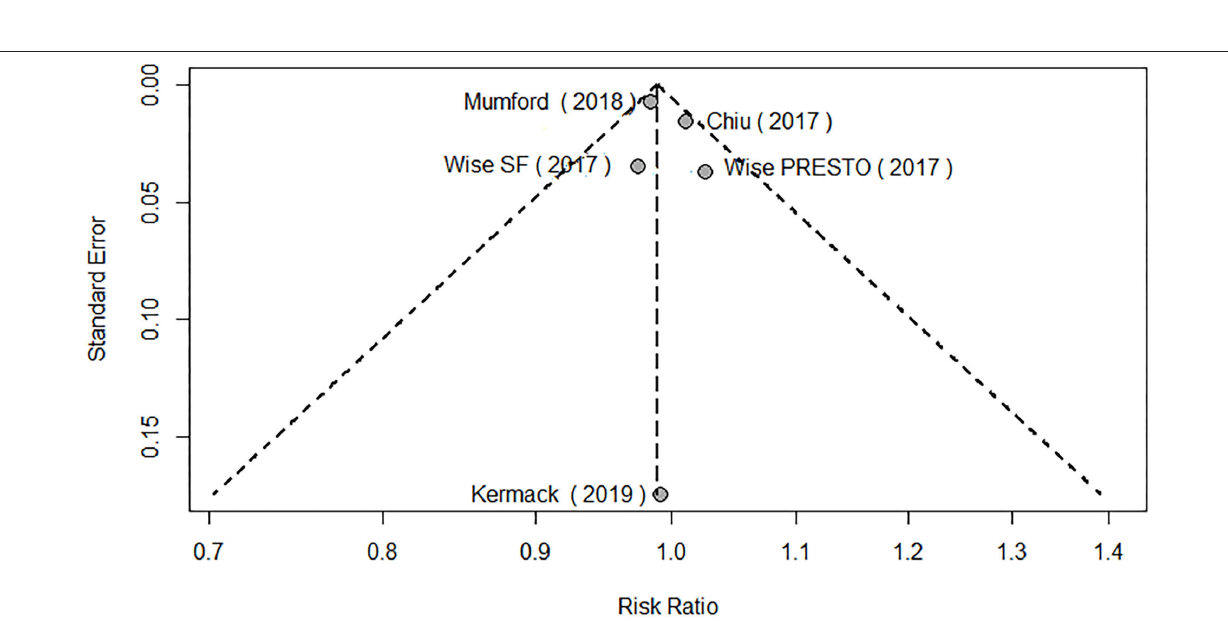
FIGURE 5 | Funnel plot of the eligible PUFA